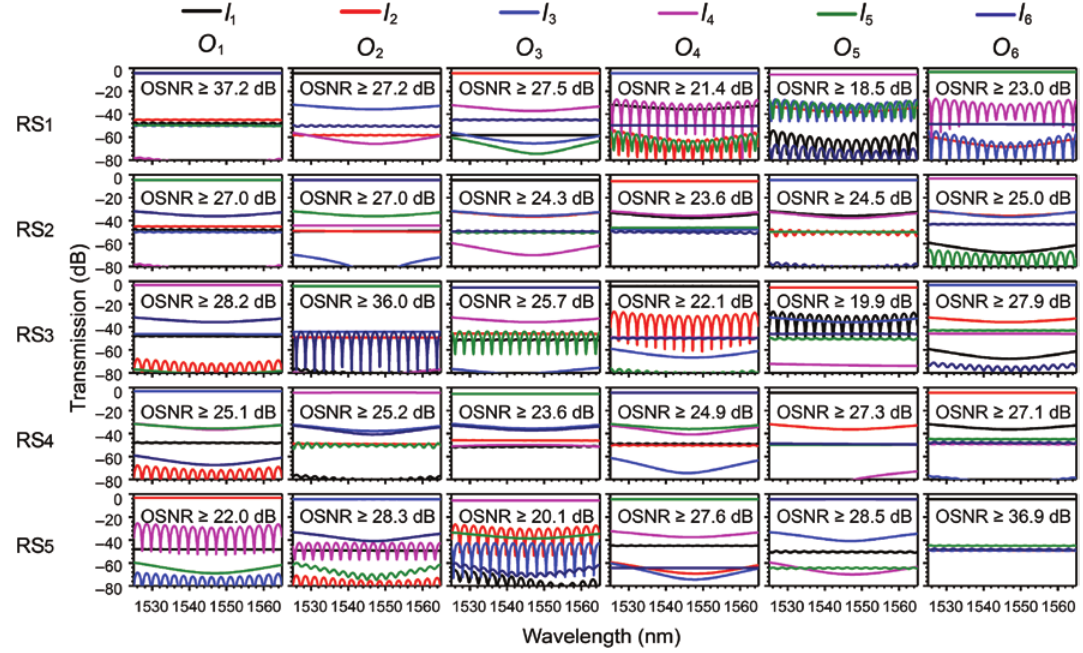
Figure 2: Simulated spectral responses in the selected five routing states (OSNR, optical signal-to-noise ratio; RS, routing